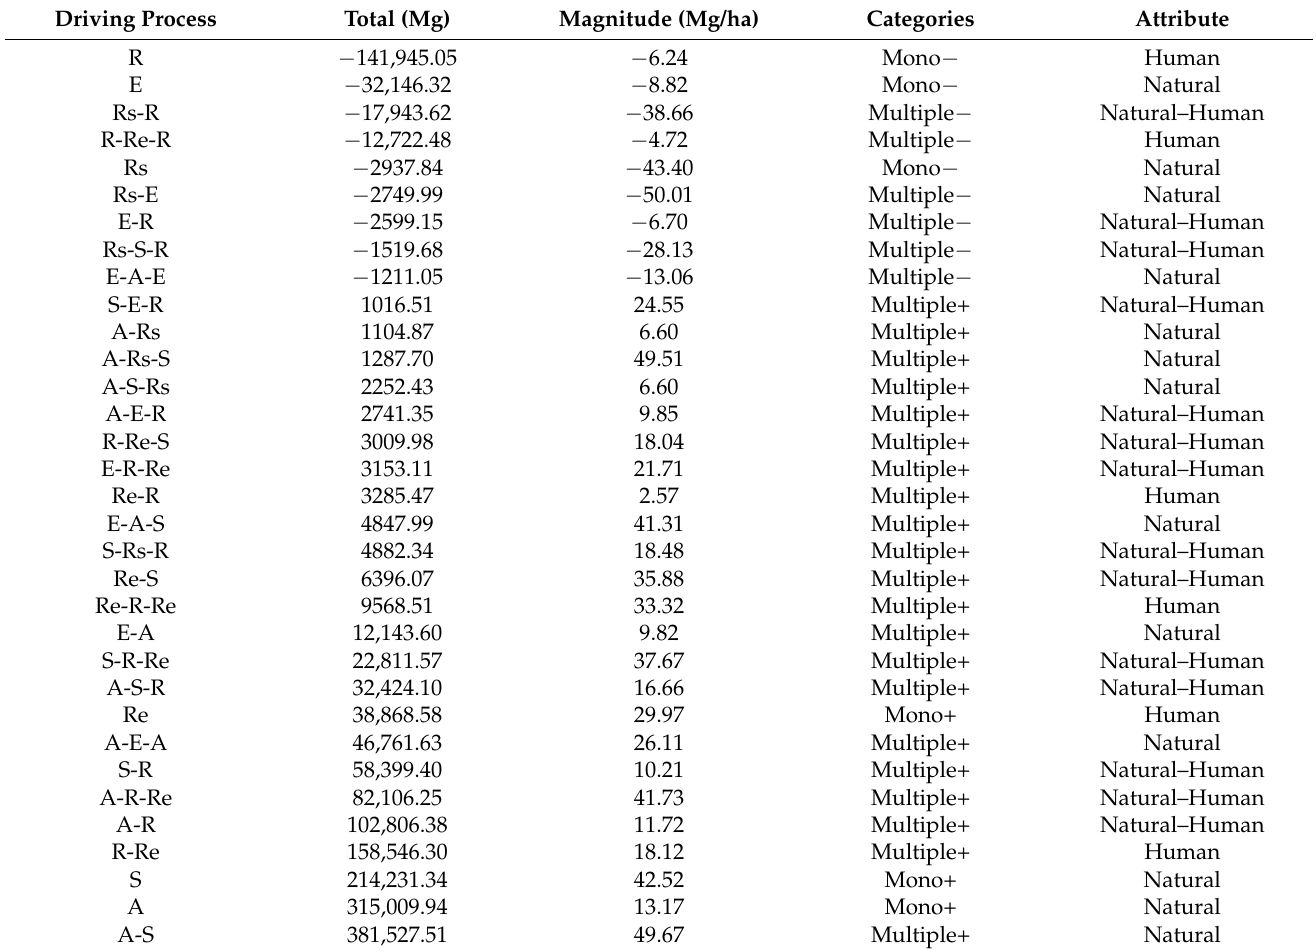
Table 5. The variation in blue carbon storage driven by the main